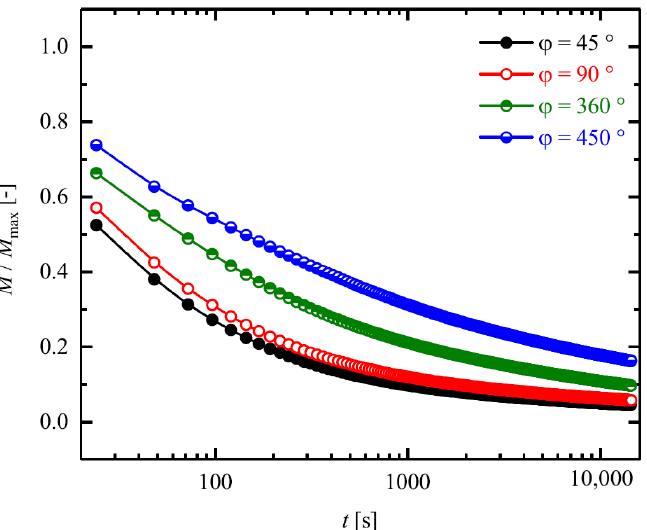
Figure 8. Evolution of the torque in relative units to deform the samples up to different deflection angles during relaxation at θ prog ◦